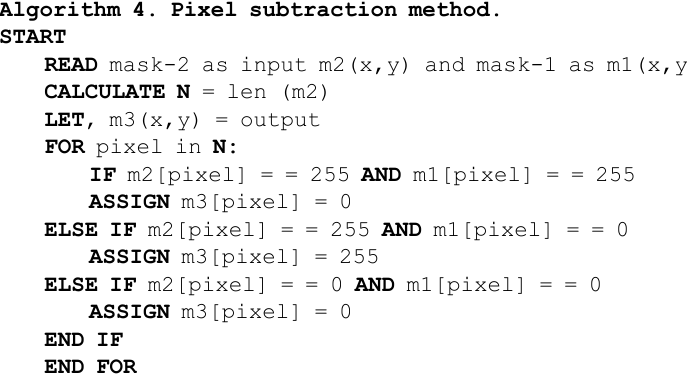
Algorithm 4. Pixel subtraction method.